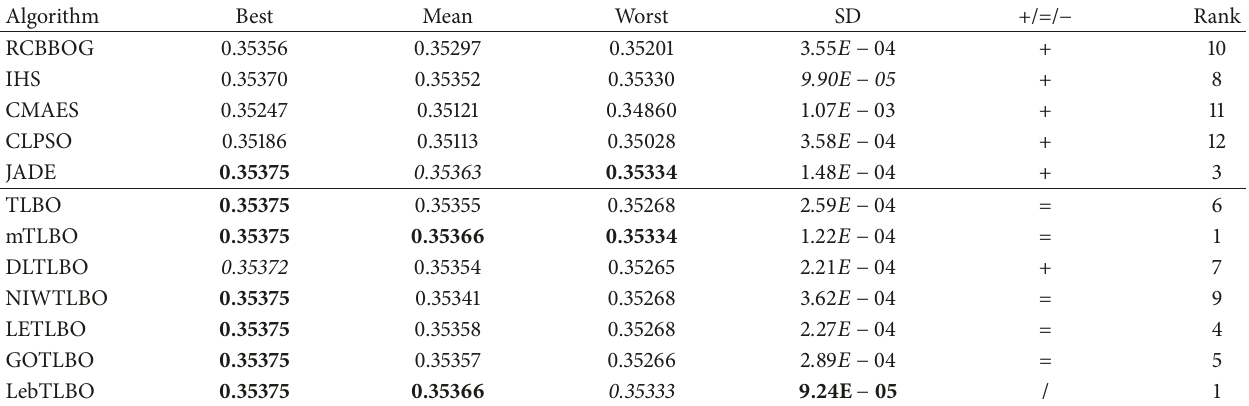
Table 9: Simulation results on the oil shale pyrolysis